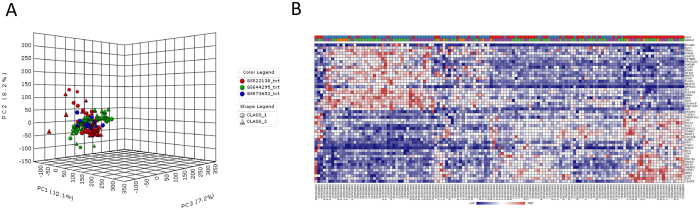
(A) Principal Component analysis of GSE73652, GSE44295 and GSE22138. CLASS1 refers to metastatic tumors and CLASS2 to localized tumor; (B) Heatmap showing the 64 differentially expressed genes as determined by Random Effect Size Analysis of GSE73652, GSE44295 and GSE22138.